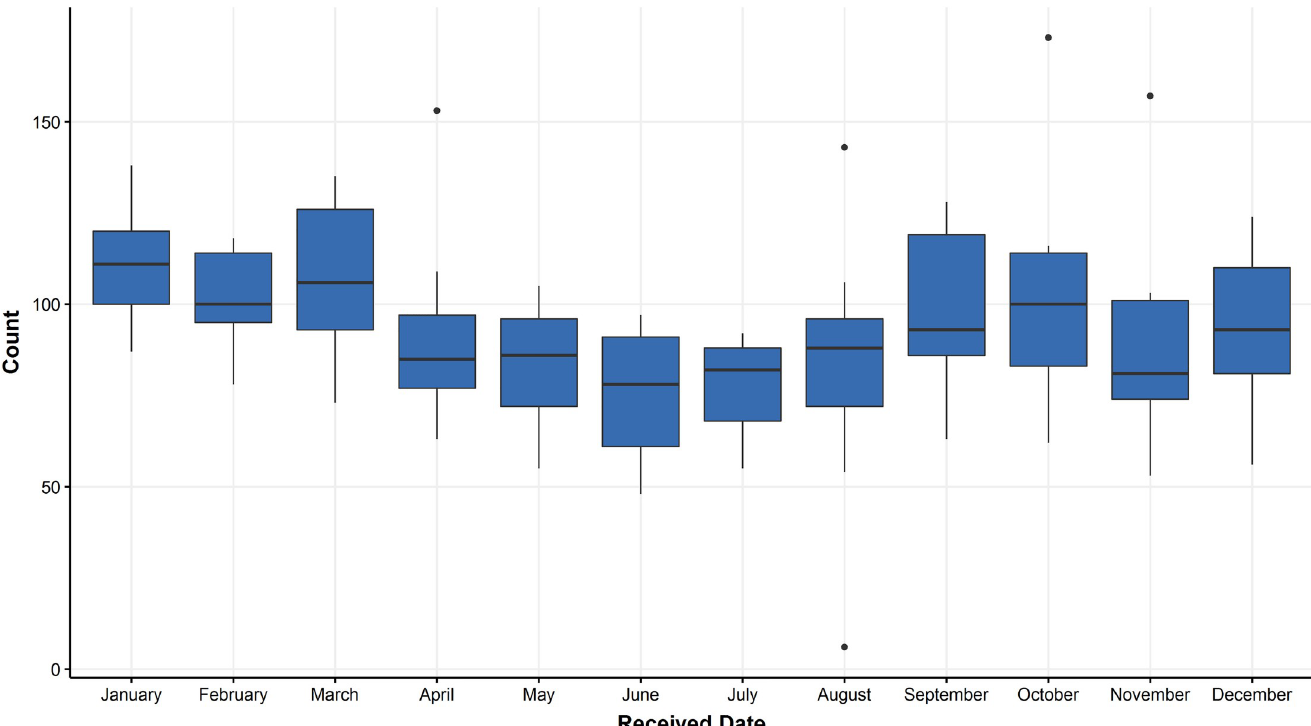
Fig 9. Monthly counts of GI syndrome. Each boxplot depicts a distribution of the total number of GI cases within a calendar month using syndromic predictions from 14 years of WVDL necropsy reports.